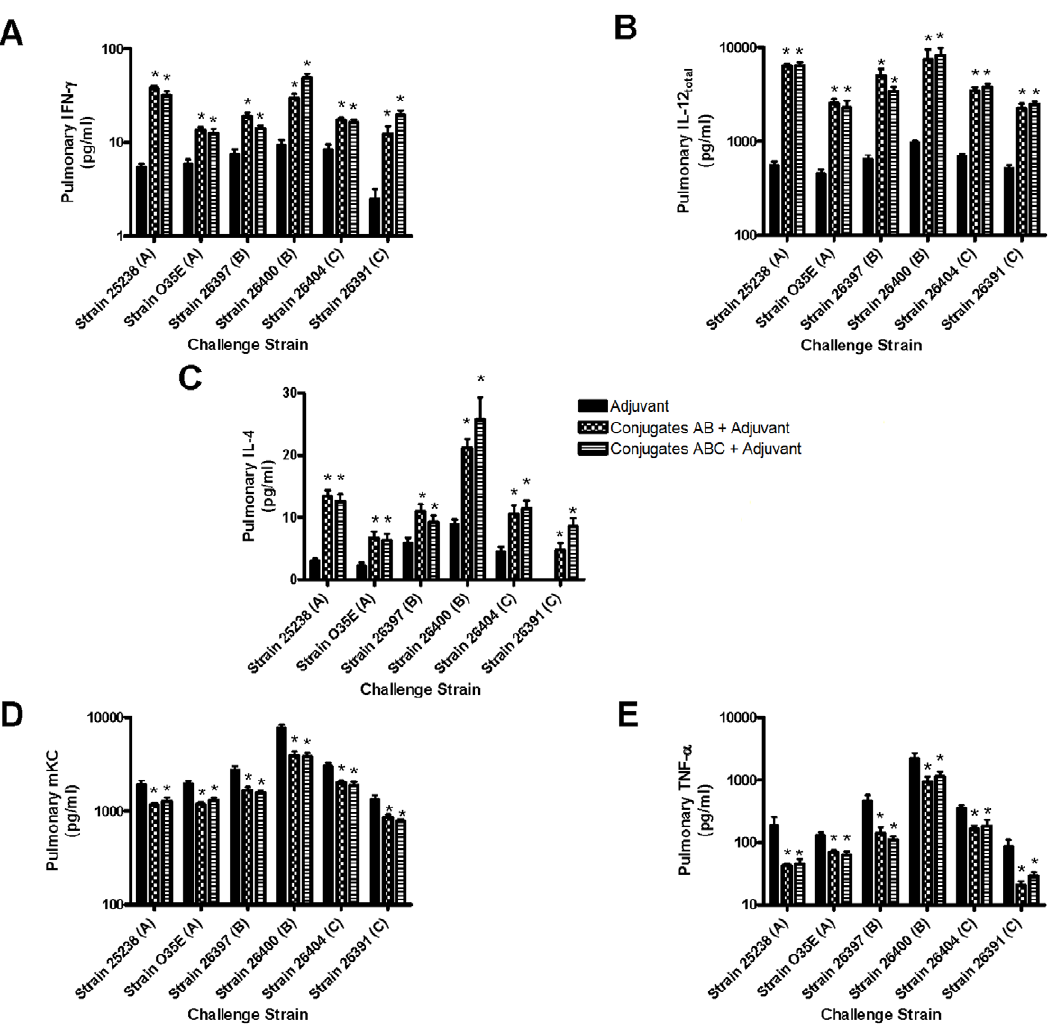
Figure 3. Pulmonary cytokine levels after challenges with three serotypes of M.catarrhalis . Mice were vaccinated (1 dose per week, 4 doses in total) with either the adjuvant cholera toxin alone (1 m g/dose/mouse) or the combined conjugates AB or ABC (2.5 m g of each carbohydrate per dose per mouse) plus adjuvant. One week after the last booster, mice were challenged with aerosolized M. catarrhalis including 25238 (type A), O35E (type A), 26397 (type B), 26400 (type B), 26404 (type C), or 26391 (type C) (5 6 10 8 to 1 6 10 9 CFU/ml). At 6 h after the challenge, mouse lungs were harvested and homogenized for detection of IFN- c , IL-12, IL-4, mKC, and TNF- a . Data are presented as mean 6 SEM. * P , 0.05 indicates the significant difference vs adjuvant control by ANOVA. Note: Pulmonary IL-4 in mice immunized with adjuvant only was below the detection limit